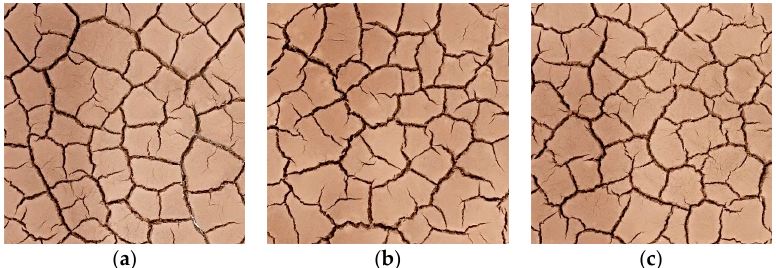
Figure 6. Fracture development morphology of soil sample after three dry–wet cycles. ( a ) Group S4 specimens; ( b ) Group S5 specimens; ( c ) Group S6 specimens.